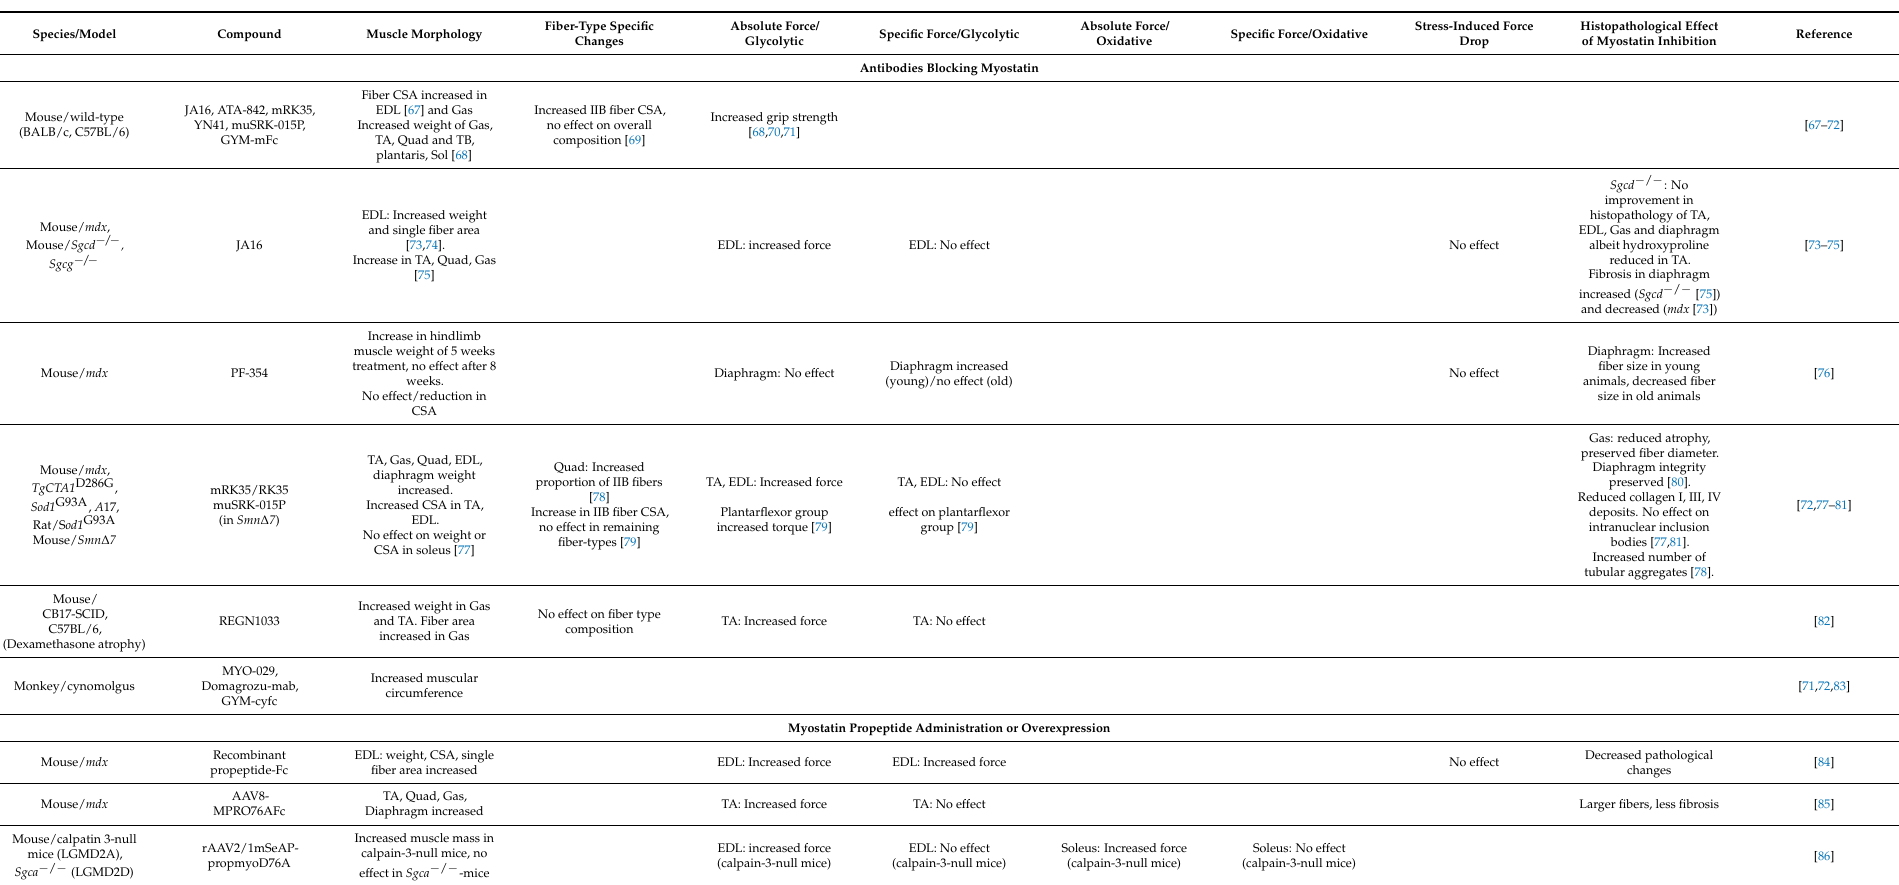
Table 1. Results of previously published data from various means of myostatin inhibition in animal